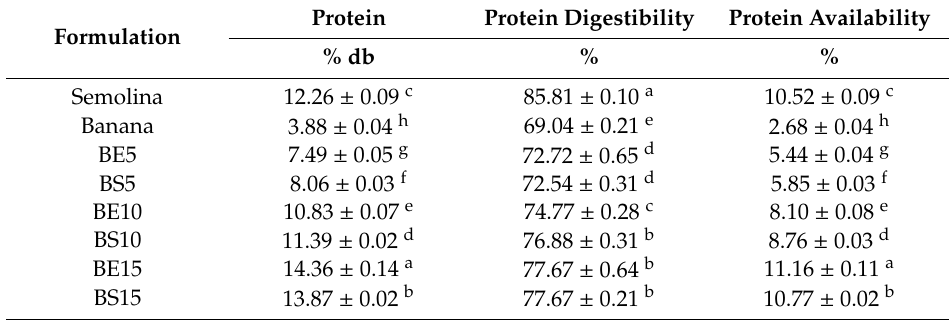
Table 2. Protein content, protein digestibility and protein availability of cooked